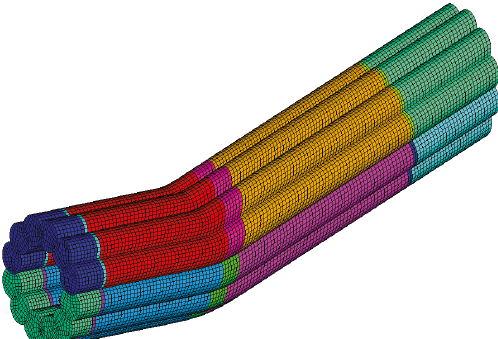
Figure 5: Grouting curtain.